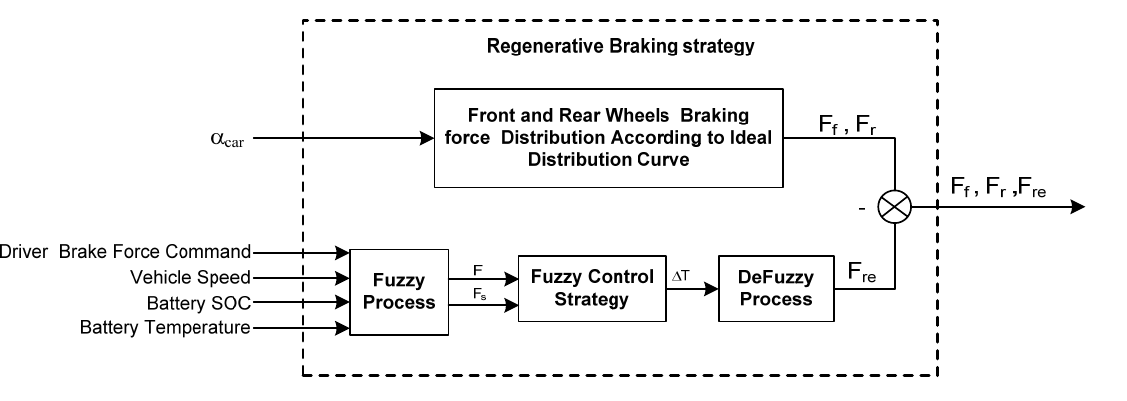
Figure 13. Structure of the control strategy